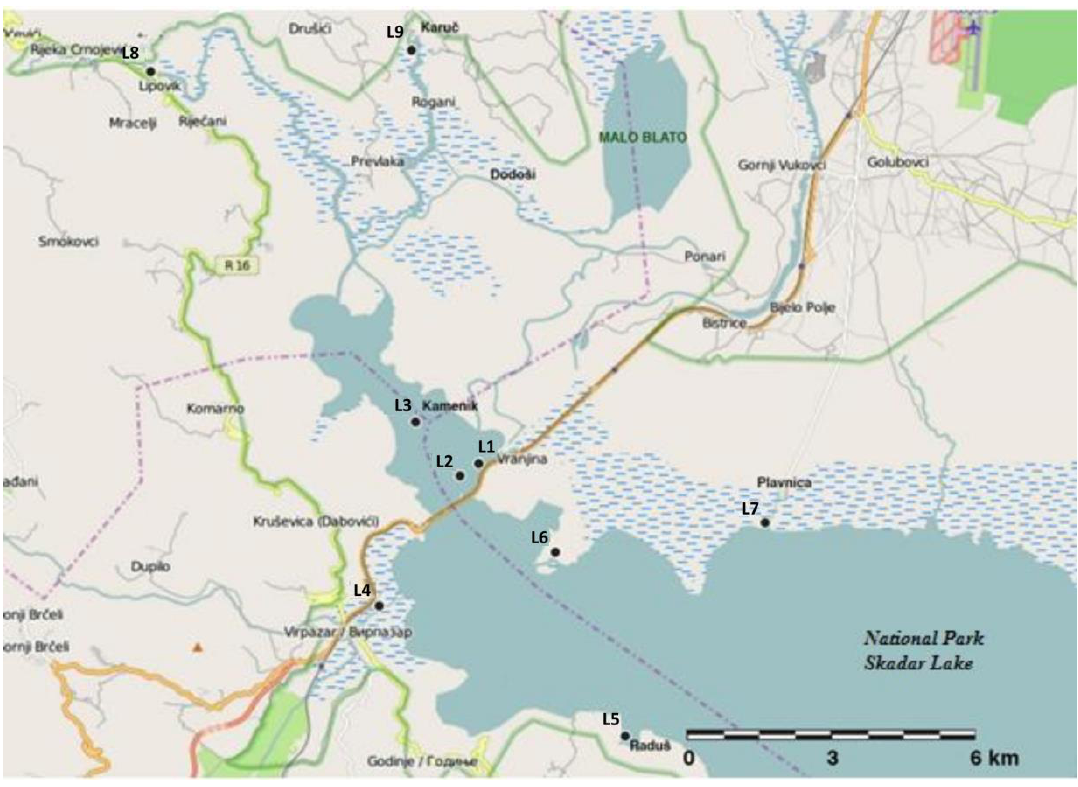
Figure 8. Map of Lake Skadar with the sampling locations.